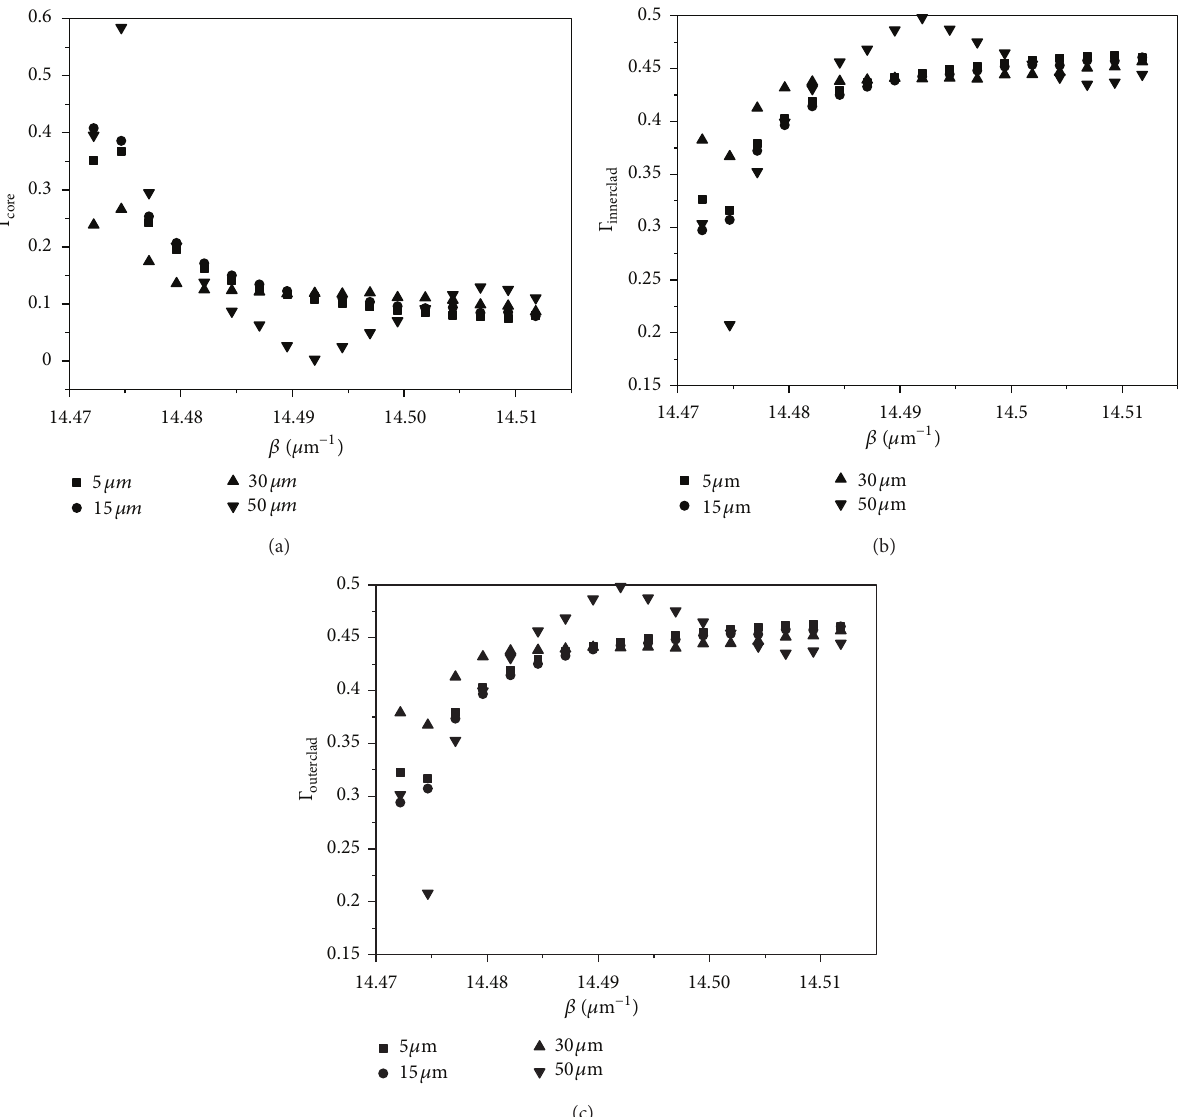
Figure 3: (a) Power confinement by the TE modes in the LCOF core. (b) Power confinement by the TE modes in the LCOF inner clad. (c) Power confinement by the TE modes in the LCOF outer